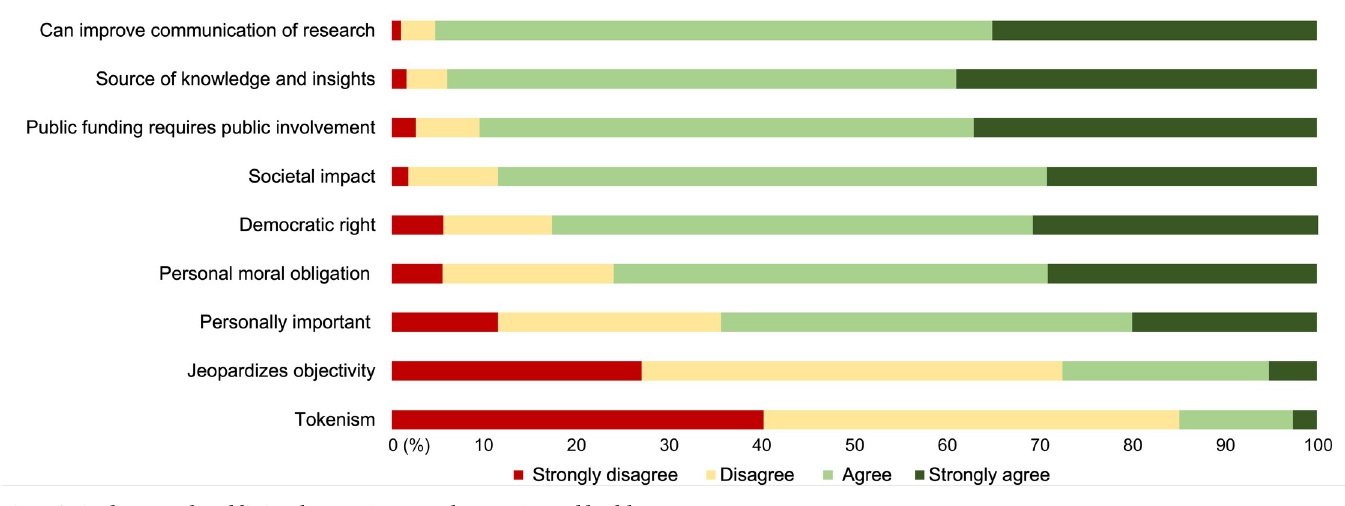
Fig 1. Attitudes towards public involvement in research on ageing and